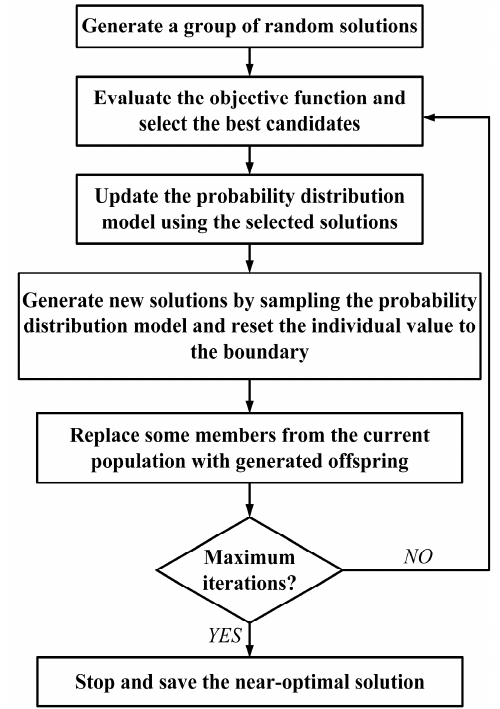
Figure 73. Intelligent charging algorithm proposed by Su et al., for a municipal charging station [186].